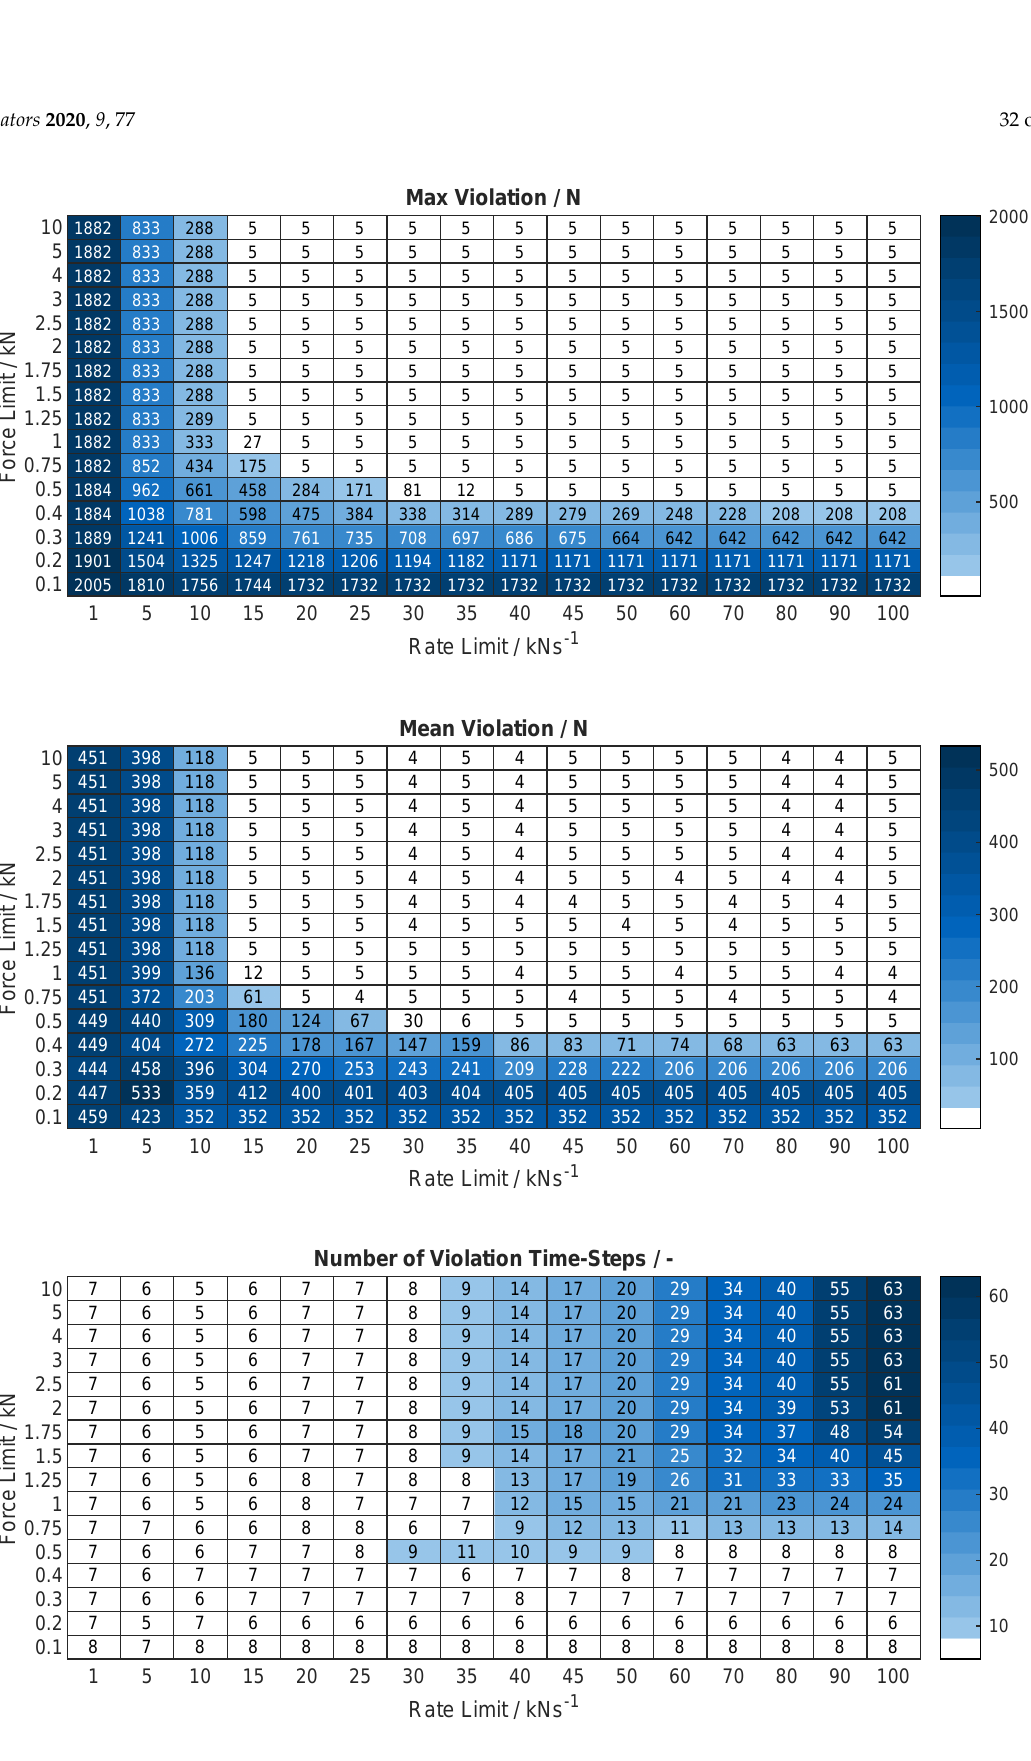
Figure A17. Dynamic wheel-load constraint violations in the 90kmh − 1 BC profile